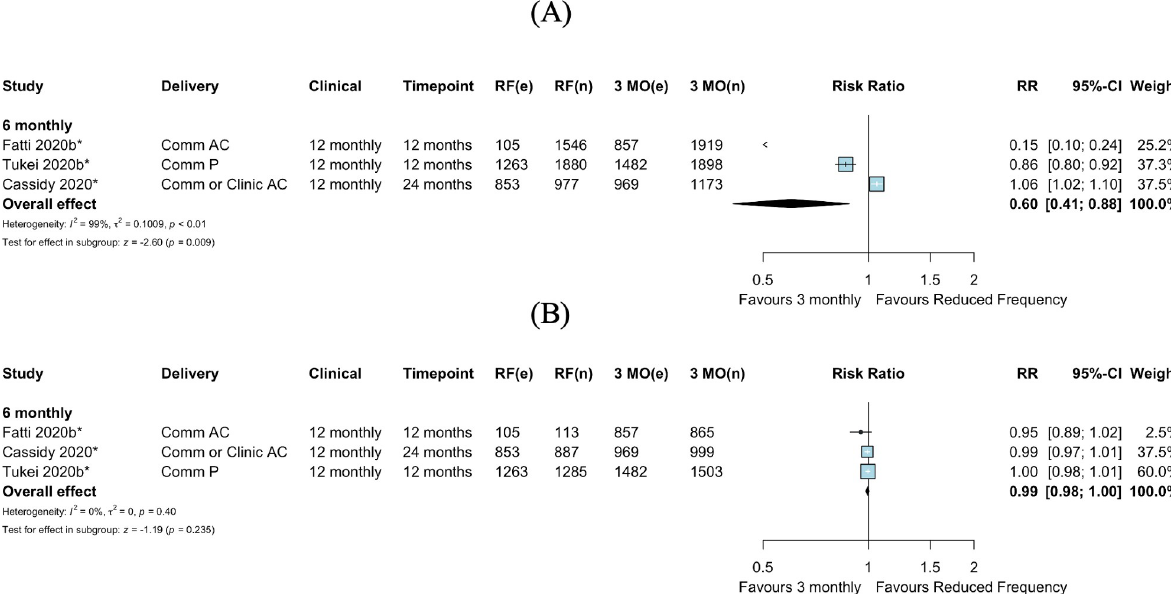
Fig 9. Viral suppression: Reduced frequency versus 3-monthly antiviral treatment refills, by study design. (A) Among those randomized. (B) Among those with viral load testing. � Cluster-adjusted RR. 3 MO, 3-monthly; AC, adherence club; Comm, community; e, number of events; n, number of participants; P, pharmacy; RF, reduced frequency; RR, risk ratio.